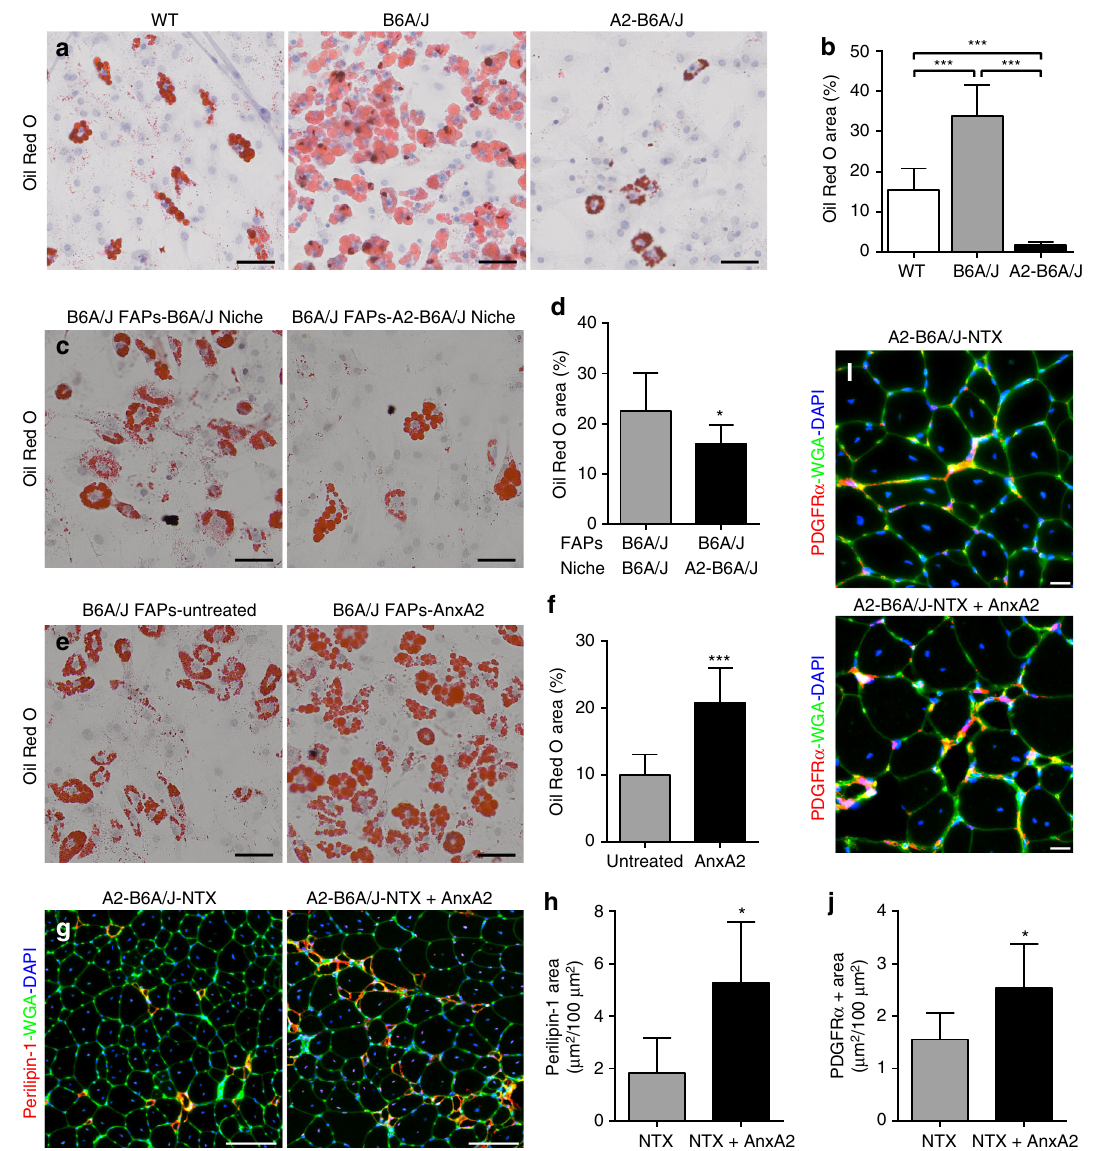
Fig. 6 AnxA2 drives FAP adipogenesis and injury-triggered lipid formation in dysferlinopathic muscle. a Oil Red O staining and b quanti fi cation of spontaneous adipogenesis of 20,000 FAPs each, isolated from 12Mo WT, B6A/J and A2-B6A/J after 10 days in culture, n = 3 replicates/genotype. Scale bar = 50 µ m. c Oil Red O staining and d quanti fi cation (normalized to 20,000 FAPs) of spontaneous adipogenesis from a 1:1 mixed culture of 24Mo B6A/J FAPs (10,000 cells) with niche cells (10,000 cells) from either 24Mo B6A/J or A2-B6A/J. Scale bar = 50 µ m. e Oil Red O staining and f quanti fi cation of spontaneous adipogenesis of 20,000 24Mo B6A/J FAPs left untreated or treated with 100 nM recombinant AnxA2. Scale bar = 50 µ m. g Perilipin-1 staining from 10Mo A2-B6A/J TA muscles 28d after single notexin injury with (NTX + AnxA2) or without (NTX) co-administration of 10 µ g recombinant AnxA2. Scale bar = 100 µ m. h Quanti fi cation of total perilipin-1 area after injury. i PDGFR α staining from 10Mo A2-B6A/J TA muscles 28d after single notexin injury and administration of 10 µ g recombinant AnxA2 compared to notexin injury alone. Scale bar = 20 µ m. j Quanti fi cation of total PDGFR α area after injury. All data presented as mean ± SD, average Oil Red area compared across genotypes by ANOVA with Holm – Sidak multiple comparisons test, all other data compared via two-tailed t -test, * p ≤ 0.05 *** p <